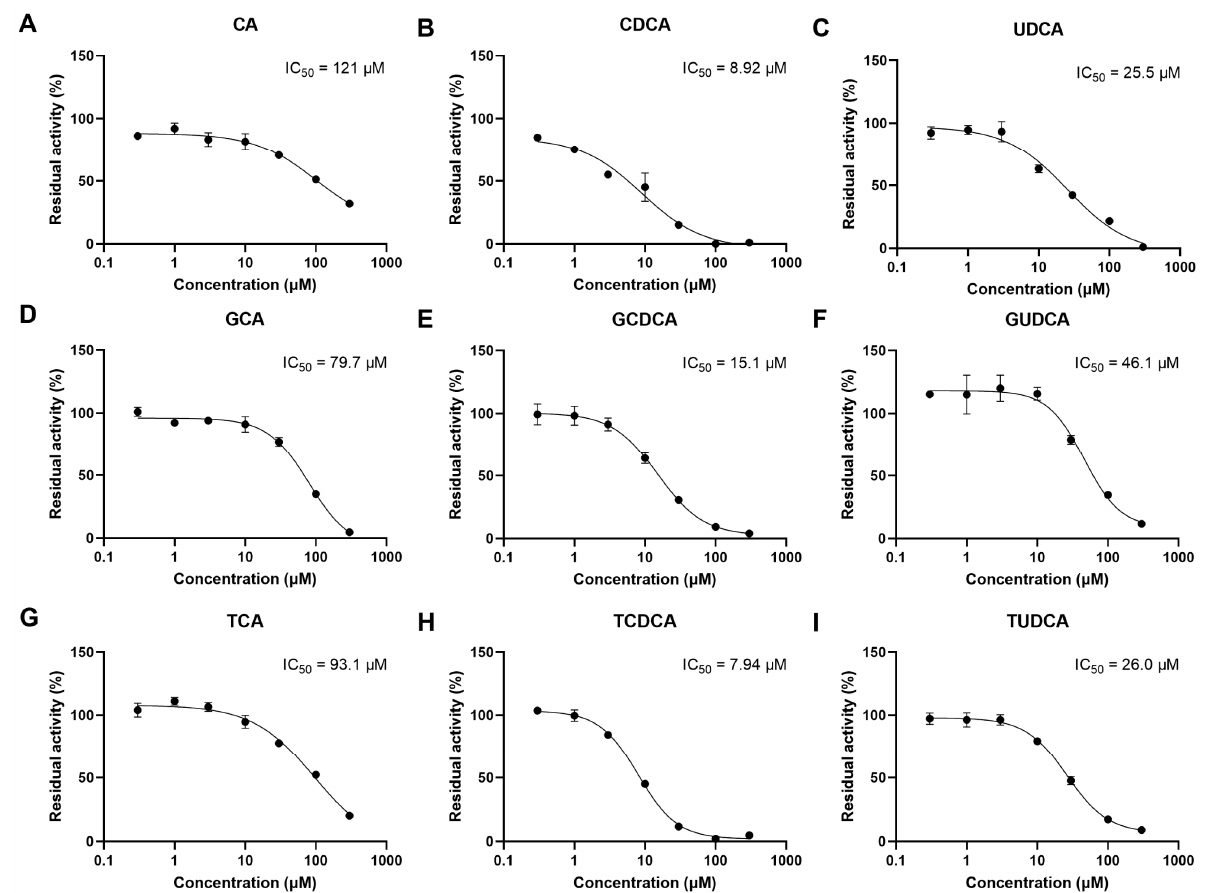
Figure 11. OATP1B3-mediated uptake of 10 µ M EZE-Ph over 5 min in the absence and presence of CA ( A ), CDCA ( B ), UDCA ( C ), GCA ( D ), GCDCA ( E ), GUDCA ( F ), TCA ( G ), TCDCA ( H ), and TUDCA ( I ). OATP1B3-mediated EZE-Ph accumulations were corrected by subtracting the nonspecific accumulation in mock-transfected HEK293 cells from that in OATP1B3-expressing HEK293 cells. The values were expressed as a percentage of the uptake in the absence of bile acids. Solid lines represent the fitted line obtained by nonlinear regression analysis. Each point was presented as mean ± S.D. ( n = 3).